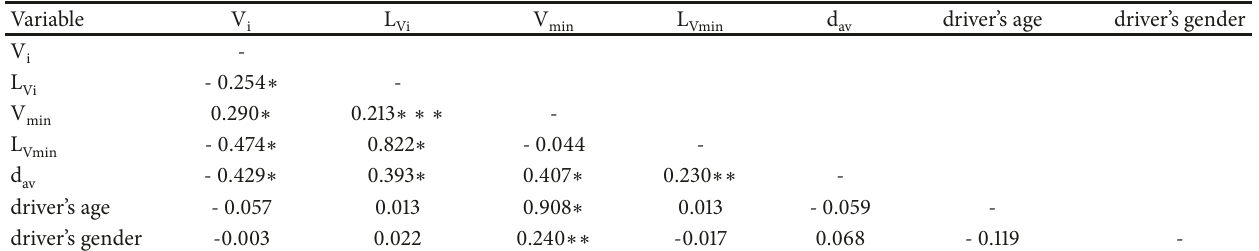
Table 2: Results of Pearson’s product-moment correlation analysis.